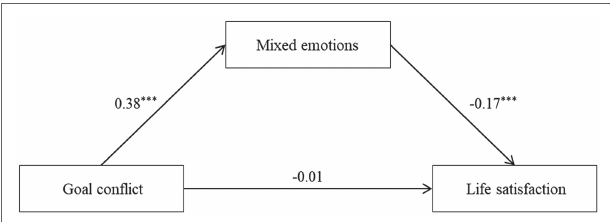
FIGURE 2 | Path coefficients of goal confliction, mixed emotions, and life satisfaction. *** p < 0.001.